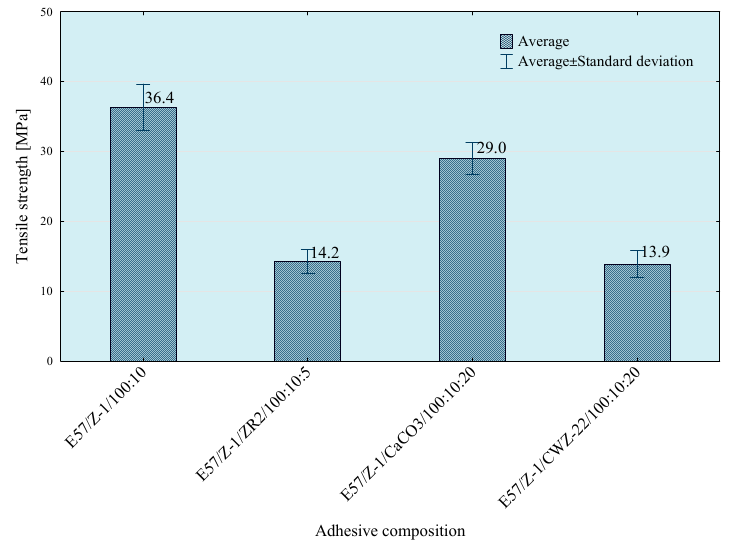
Figure 18. Results of tests of average tensile strength of compositions prepared with 5 mixing methods at 460 rpm.